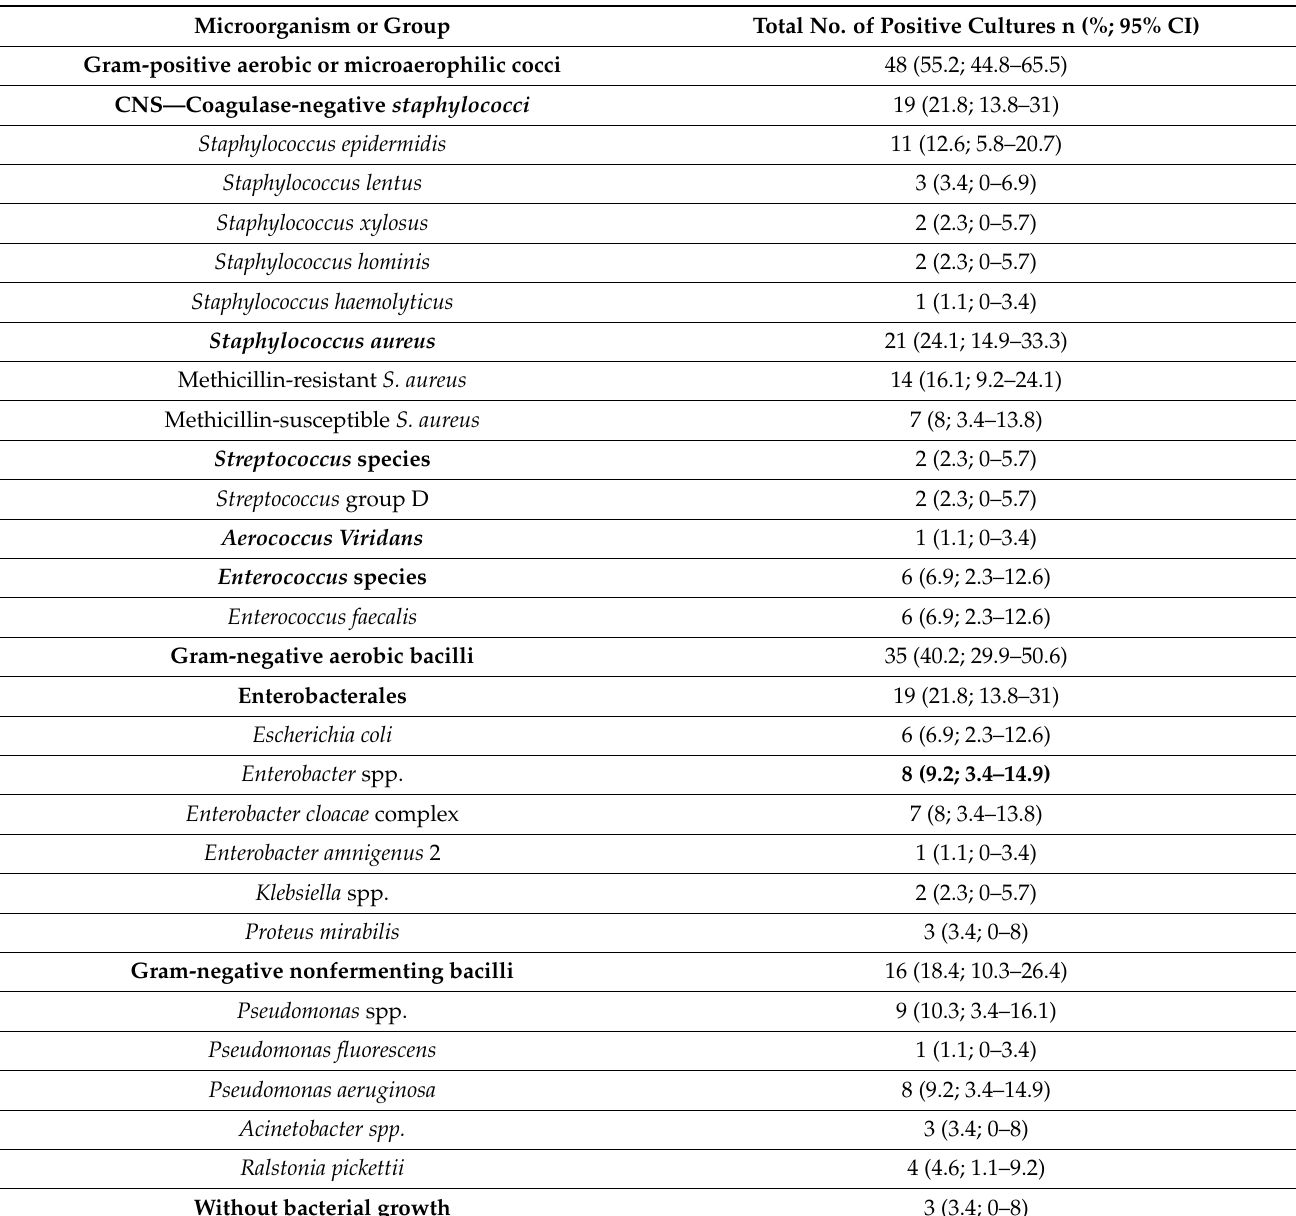
Table 3. Lists of causative microorganisms of PJIs during the study period (2016 through 2021). Microorganism or Group Total No. of Positive Cultures n (%; 95%